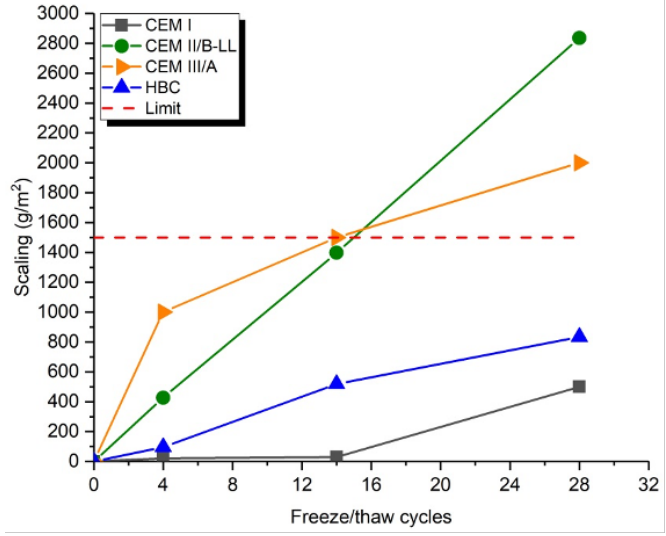
Figure 4. Resistance to freeze/thaw attack with deicing salt (CDF method).